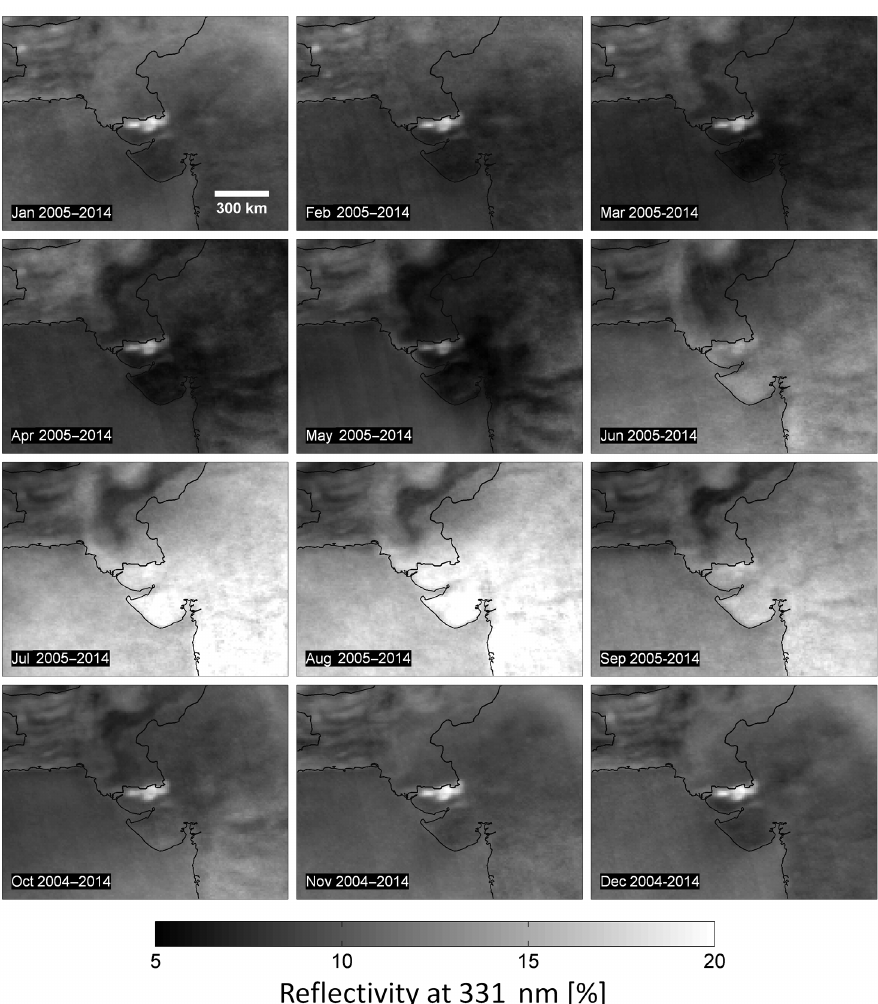
Figure 4. Seasonal variation of the monthly mean reflectivity at 331nm over the Rann of Kutch as seen by OMI during 2004–2014 (same data selection as in Fig. 3, i.e. for CF < 0.3). Only the Great Rann of Kutch can be clearly identified due to its bright surface compared to the surrounding areas. During the monsoon (July–September), wide areas are still affected by clouds as indicated by the increased background, including the Rann area. It is important to note that enhanced BrO VCDs in Fig. 3 appear only in certain parts of the salt marsh (area of enhanced reflectivity) and especially for rather low reflectivity in April and